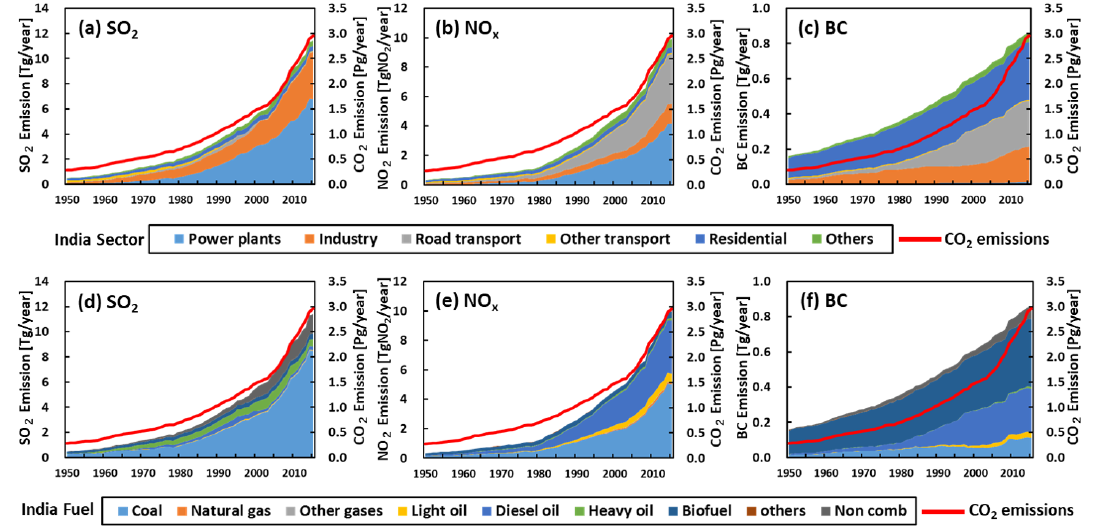
Figure 4. Emissions of (a, d) SO 2 , (b, e) NO x , and (c, f) BC from each major sector category (a, b, c) and fuel type (d, e, f) in India from 1950 to 2015 (“Non comb”: non-combustion sources). Red lines in the panels are total CO 2